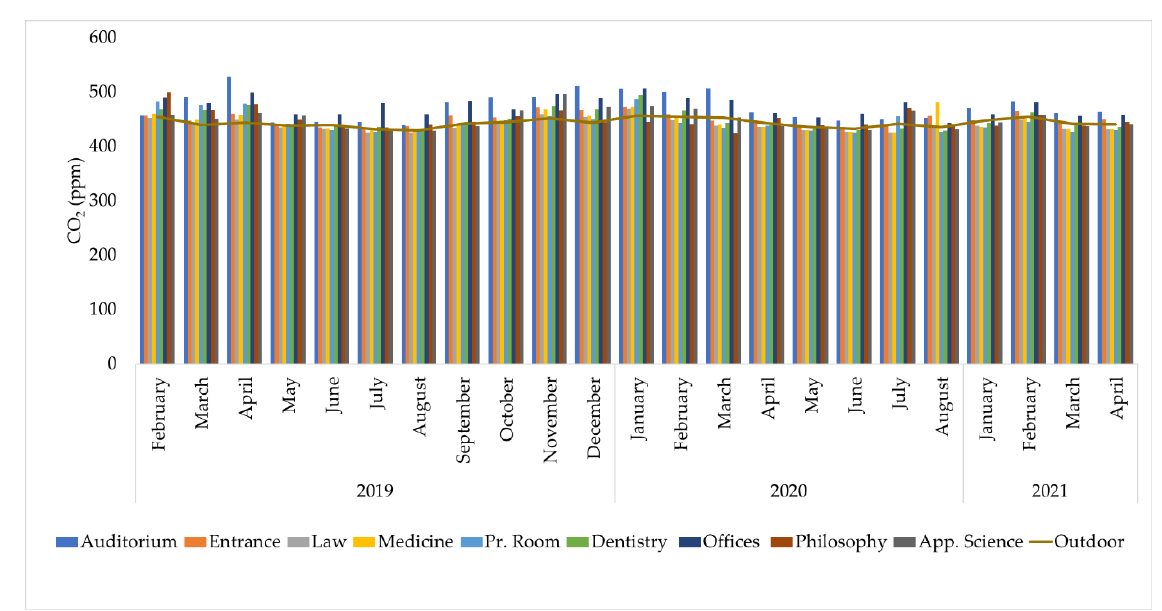
Figure 7. Carbon dioxide levels in every hall of the museum for the entire monitoring process.